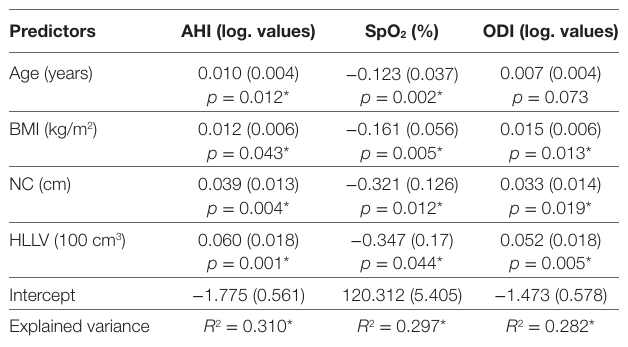
Table 2 | Most significant anthropometric predictors of AHI, SpO 2 , and ODI according to multiple linear regression analyses.